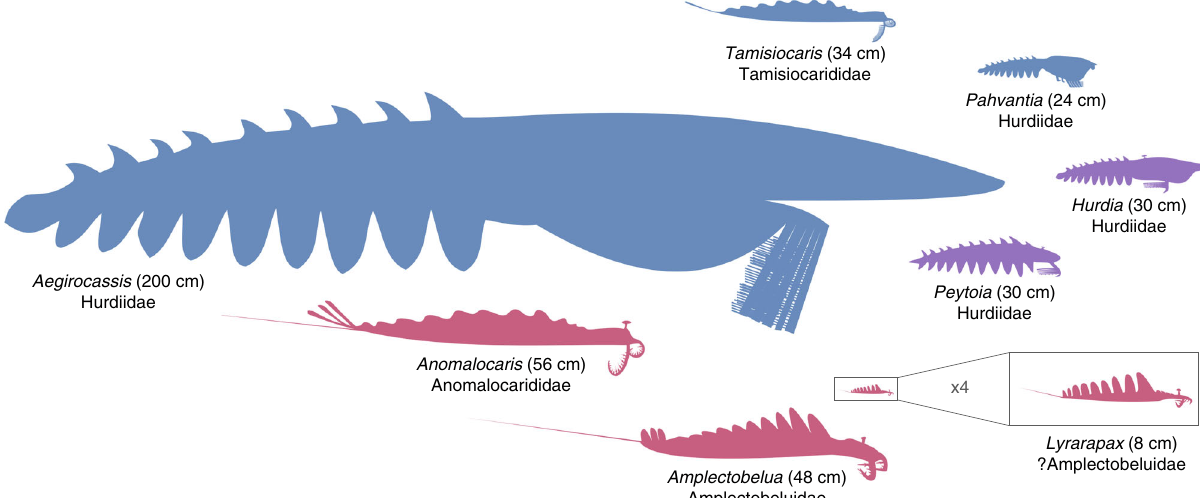
Fig. 5 Diversity of sizes and feeding habits in radiodonts. As exempli fi ed by Aegirocassis and Pahvantia , there is no obvious relationships between size and feeding strategy in this group. Raptorial predators are represented in red, sediment sifters in purple, and suspension feeders in